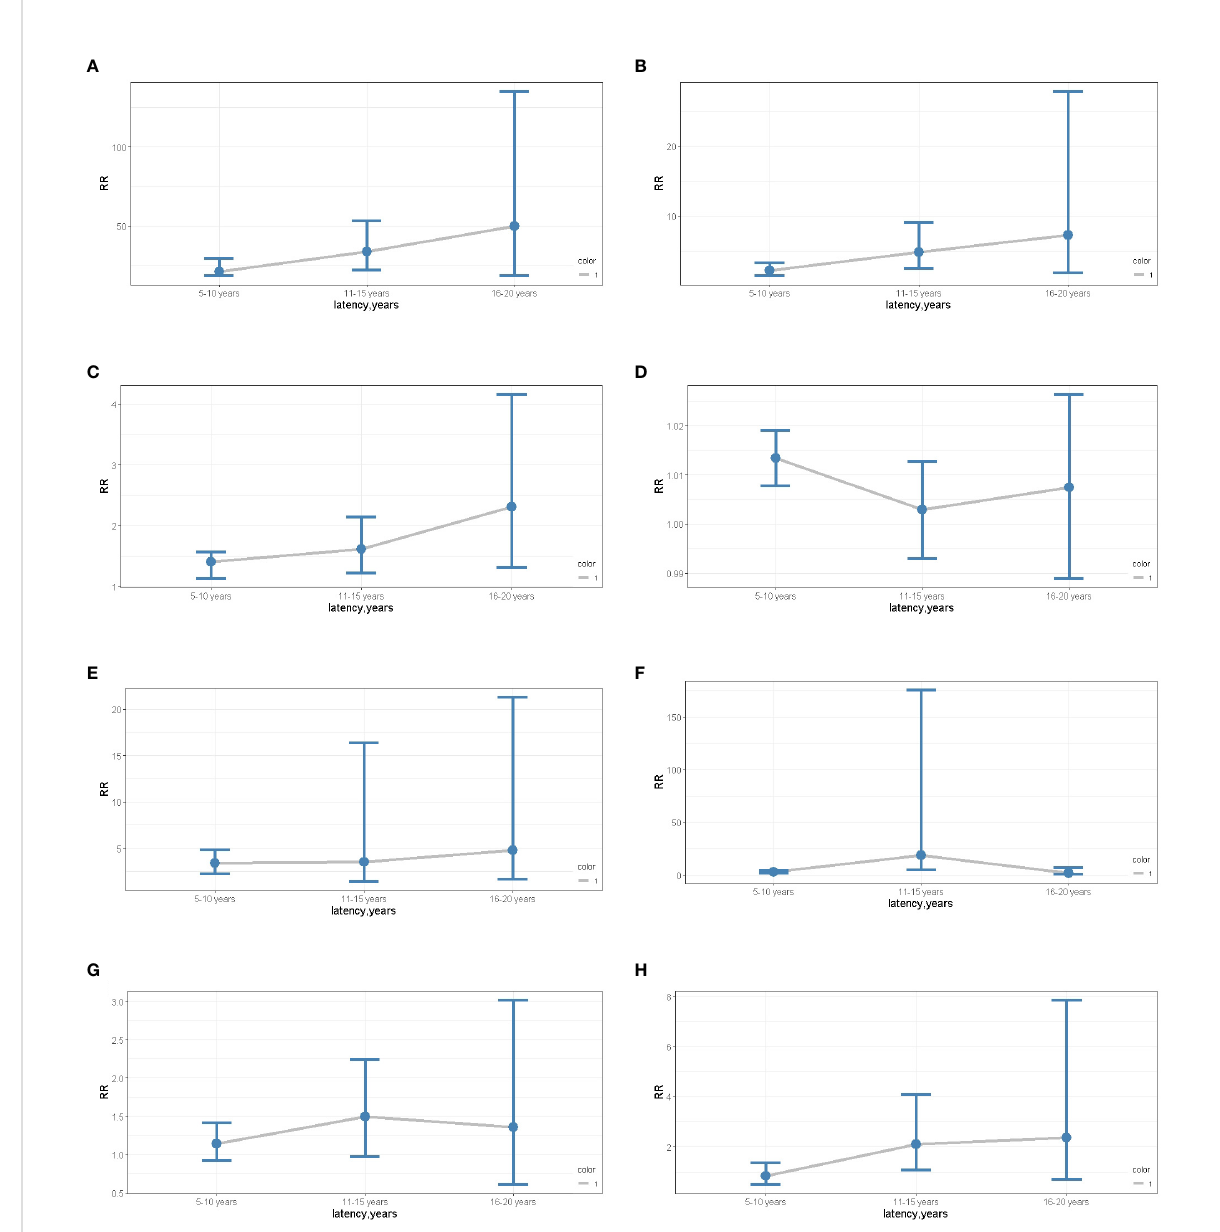
FIGURE 7 (A) The dynamic RR plots of White races (compared to the black). (B) the dynamic RR plots of other races (compared to the black); (C) the dynamic RR plots of receiving surgery (compared to non-surgery patients); (D) the dynamic RR plots of age older than 50 years old (compared to age younger than 50 years old patients); (E) the dynamic RR plots of localized stage (compared to distant metastases); (F) the dynamic RR plots of regional stage (compared to distant metastases); (G) the dynamic RR plots of SCC (compared to the ADC); (H) the dynamic RR plots of ASC (compared to the